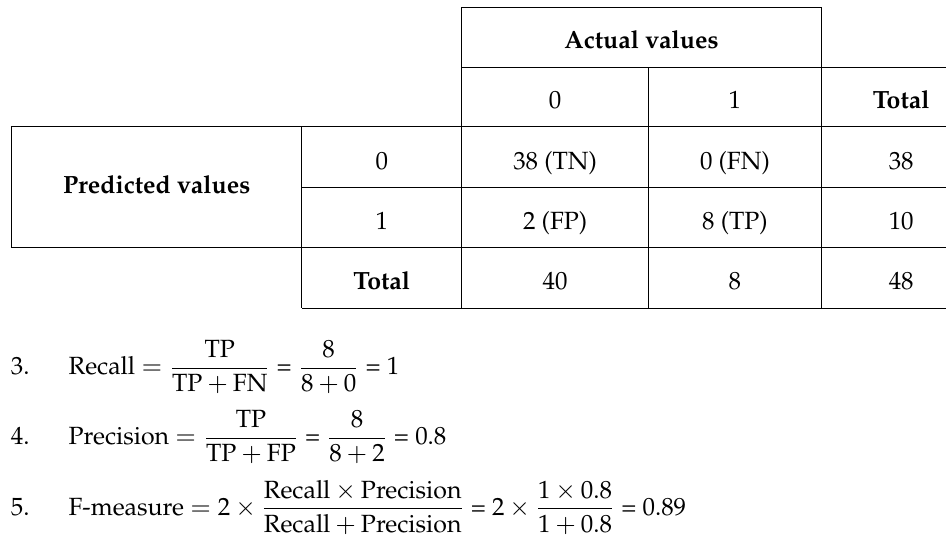
Table 3. Confusion matrix relating to the VANET network. TP: True Positive; TN: True Negative; FP: False Positive; FN: False